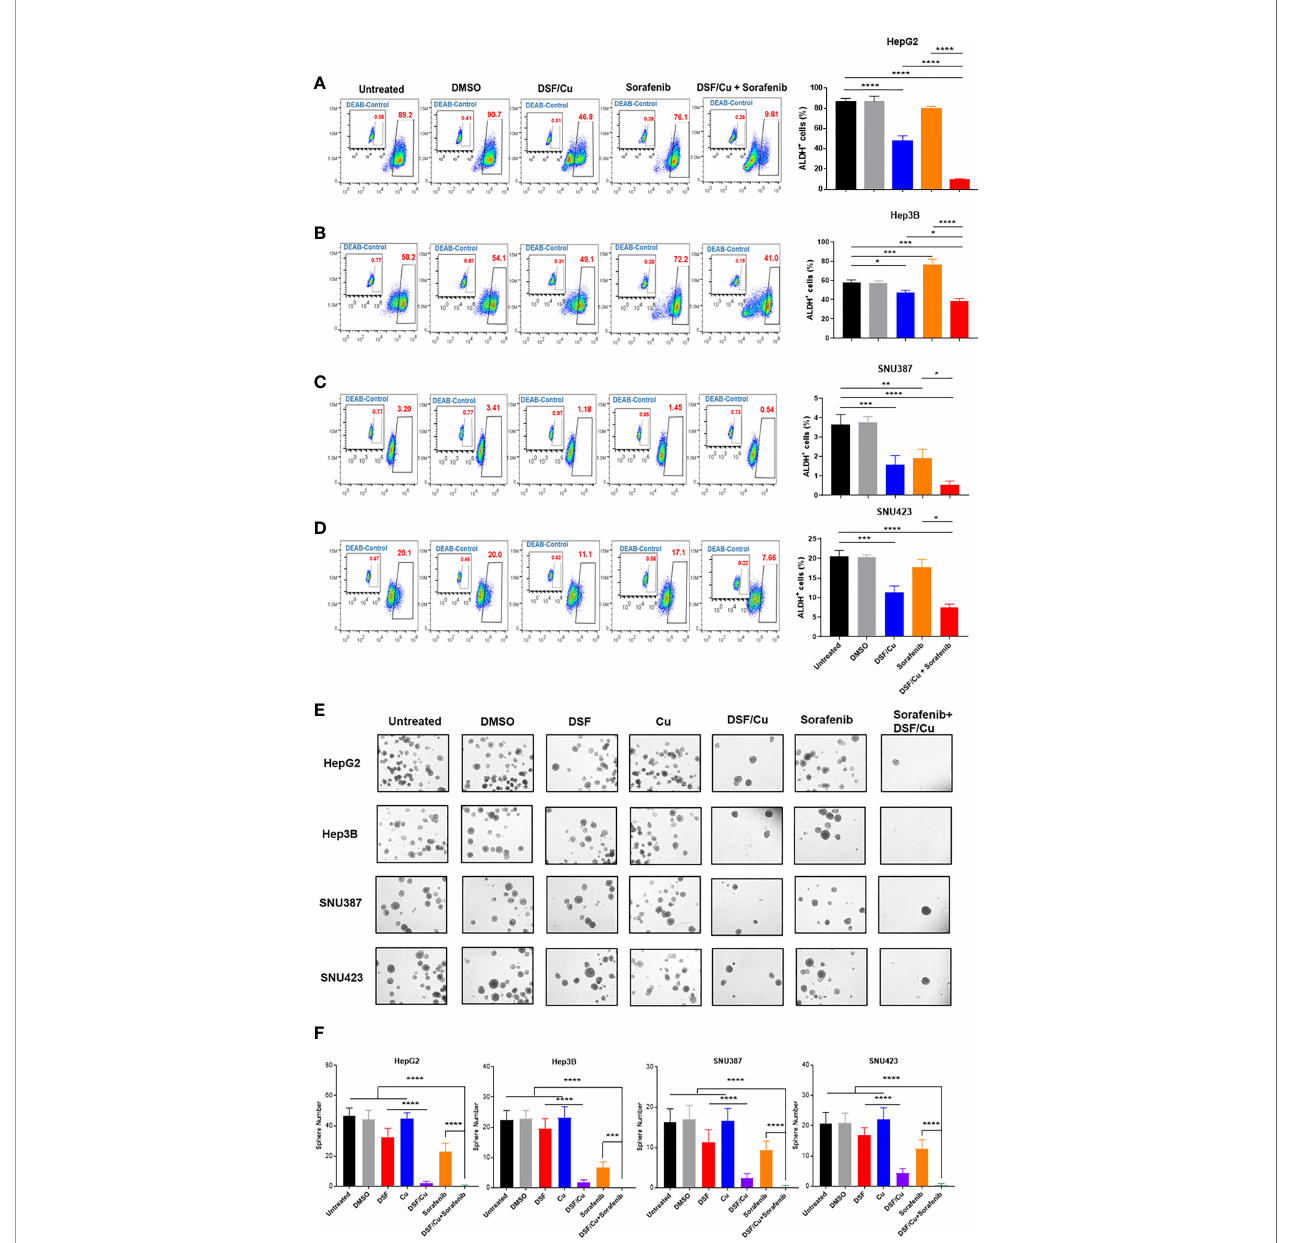
FIGURE 2 | HCSCs are sensitive to DSF/Cu and sorafenib. The HCC cell lines HepG2 (A) , Hep3B (B) , SNU387 (C) , and SNU423 (D) were treated as indicated, and ALDH + cells was measured using fl ow cytometry. Sphere formation assays were performed in six-well plates by seeding treated cells and culturing for 14 days. Spheres were quanti fi ed by counting sphere numbers per well on day 14 (E, F) . All experiments were performed in triplicate for each cell line, and data are shown as mean ± SD. *p<0.05, **p<0.01, ***p<0.001,